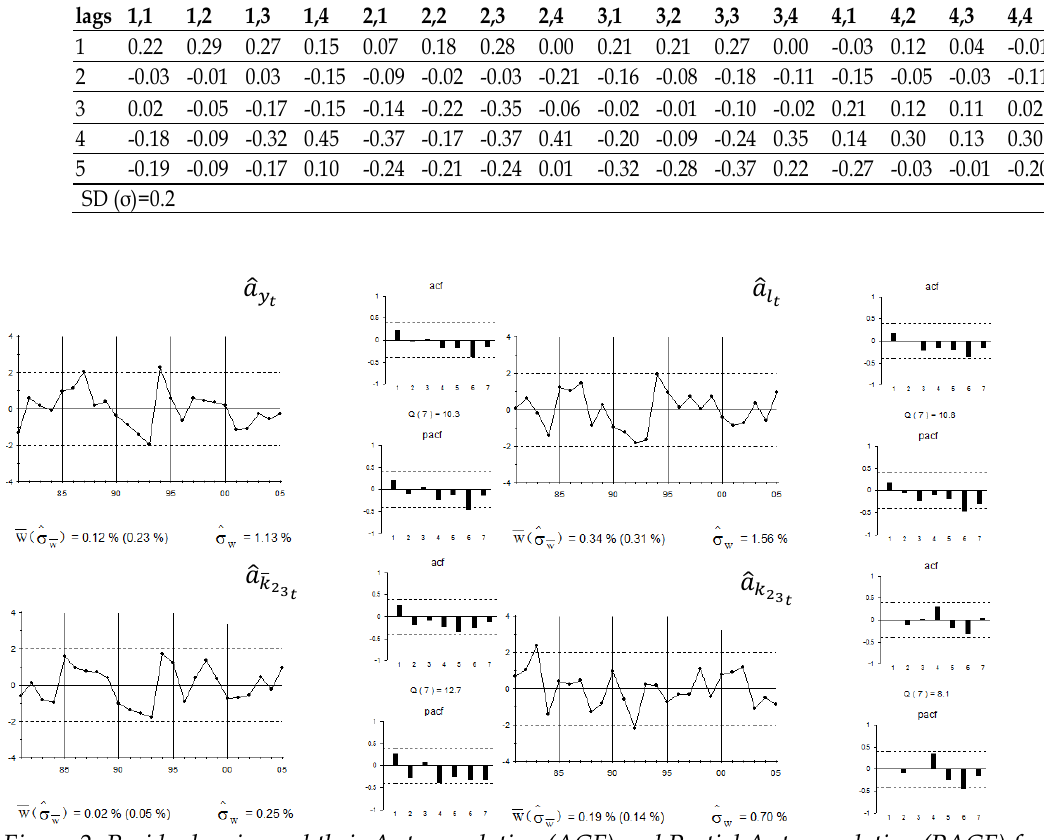
Figure 2. Residual series and their Autocorrelation (ACF) and Partial Autocorrelation (PACF)